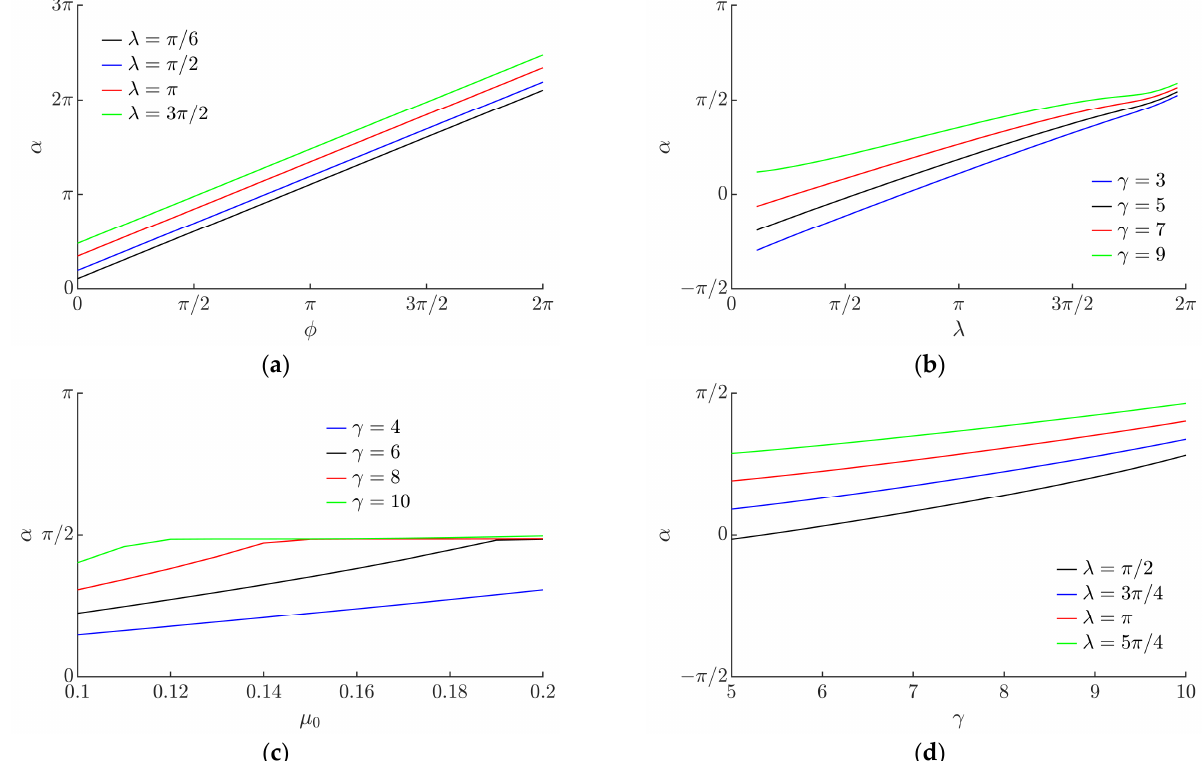
Figure 10. Displacement angle α depending on: ( a ) ϕ when μ 0 = 0.1, γ = 8.8, ⟨ μ m ⟩ / μ 0 = 0.25; ( b ) λ when μ 0 = 0.1, ϕ = 0, ⟨ μ m ⟩ / μ 0 = 0.25; ( c ) μ 0 when ⟨ μ m ⟩ / μ 0 = 0.25, ϕ = 0, λ = π /2; ( d ) γ when μ 0 = 0.1, ϕ = 0, ⟨ μ m ⟩ / μ 0 = 0.25.